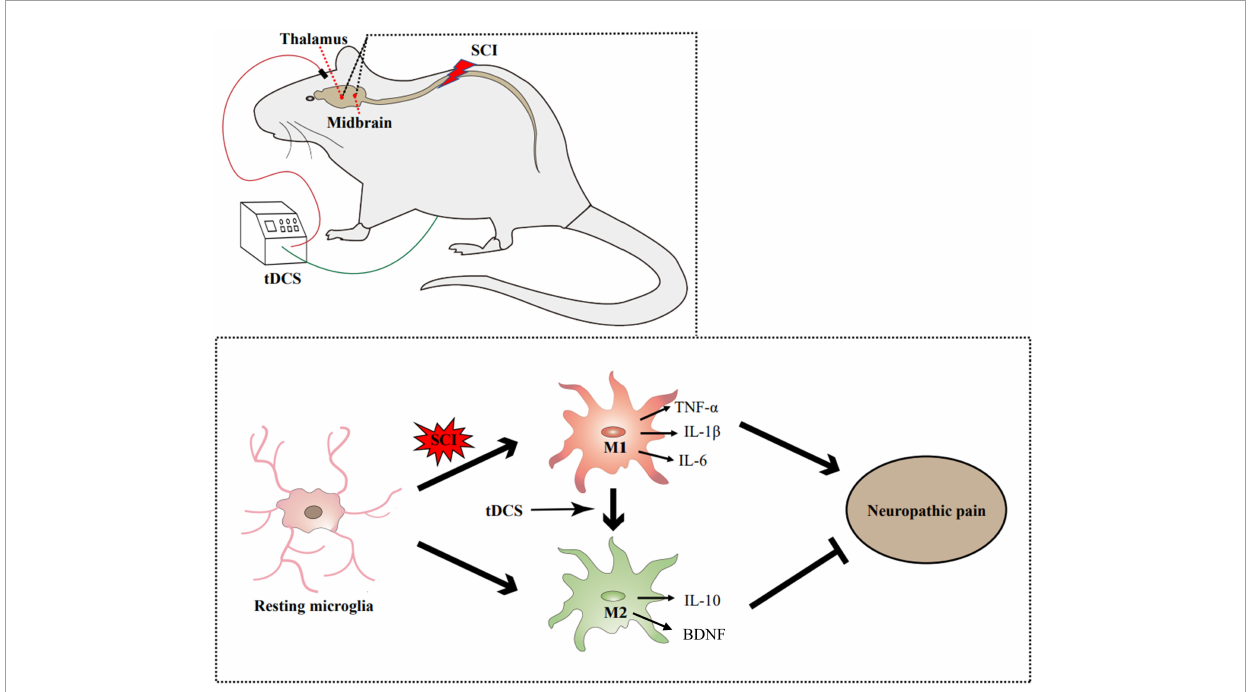
FIGURE7 Illustrative mechanism for tDCS to alleviate the neuropathic pain induced by SCI. SCI can promote the activation of microglia and transform into the M1 phenotype. tDCS can change the polarization direction of microglia in the thalamus and midbrain. By reducing the proportion of M1 phenotype and increasing the proportion of m2 phenotype, tDCS can reduce the content of proinflammatory cytokines (TNF- α , IL-1 β , and IL-6), increase the content of anti-inflammatory cytokine (IL-10) and neurotrophic factors (BDNF), and finally alleviate the neuropathic pain induced by